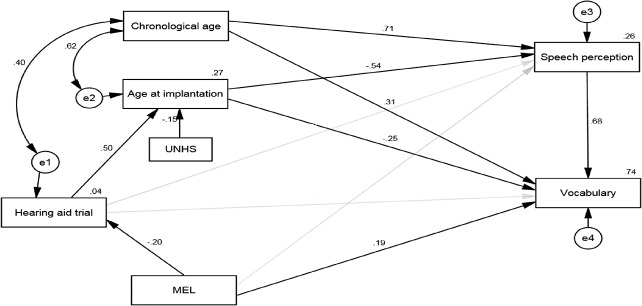
Final model describing the relationships among demographical variables, speech perception and vocabulary ability.Standardized path coefficients are presented at the midpoint of the unidirectional arrow paths (N = 115). Values noted besides the endogenous variables represent the percentage of variance accounted for each variable. The insignificant paths are shown in gray and their path coefficients are not presented. e represents the residuals in the prediction of endogenous factors from exogenous factors. Note: UNHS: universal newborn hearing screening, PTA: pre-implant hearing level, MEL: maternal education level.